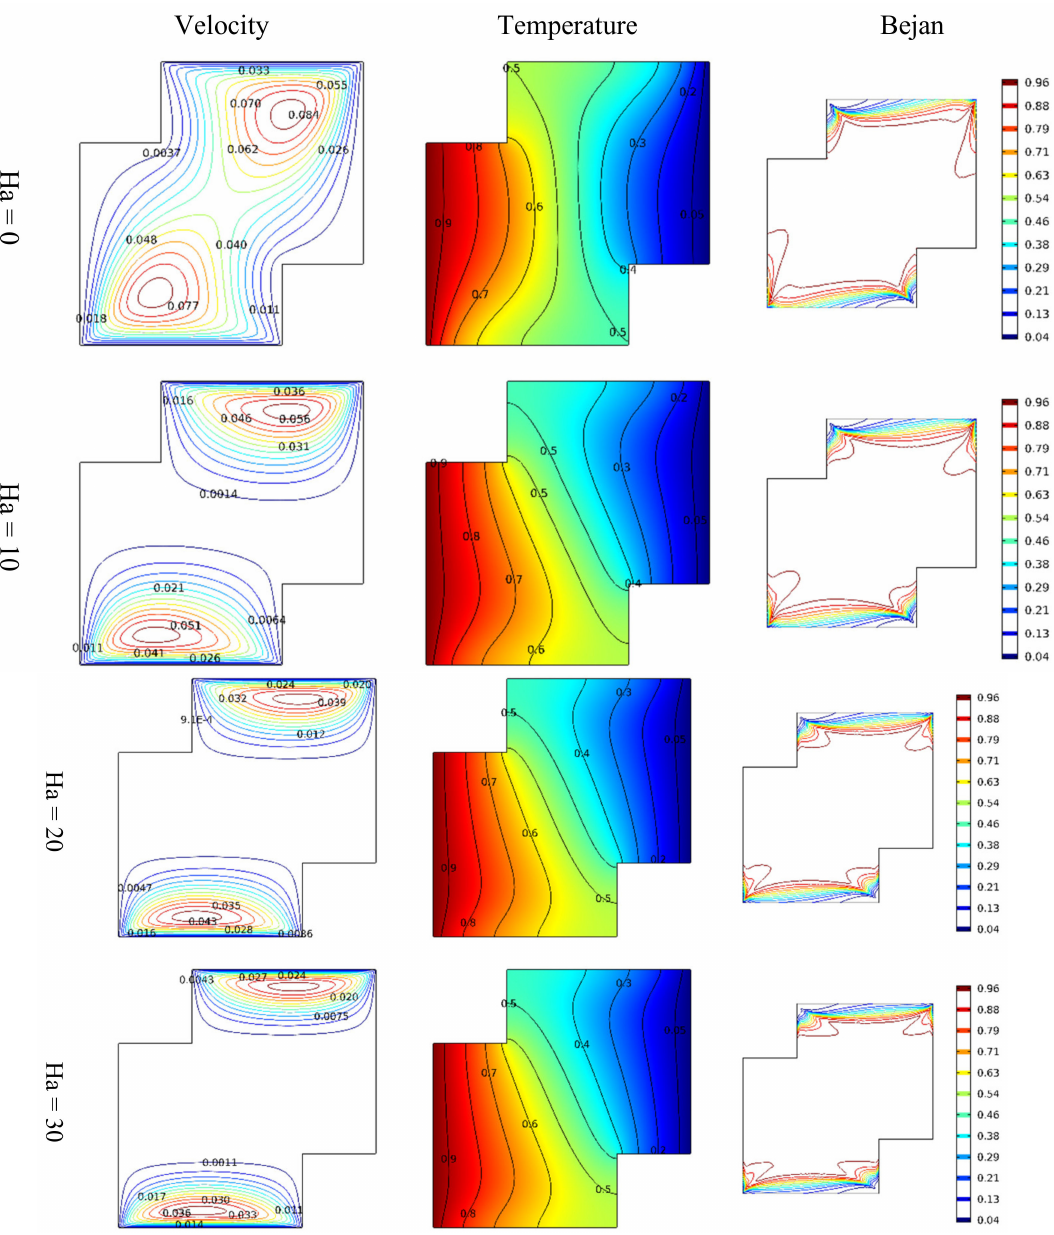
Figure 4. Variations in the velocity, temperature distribution, and entropy generation at different levels of Hartmann